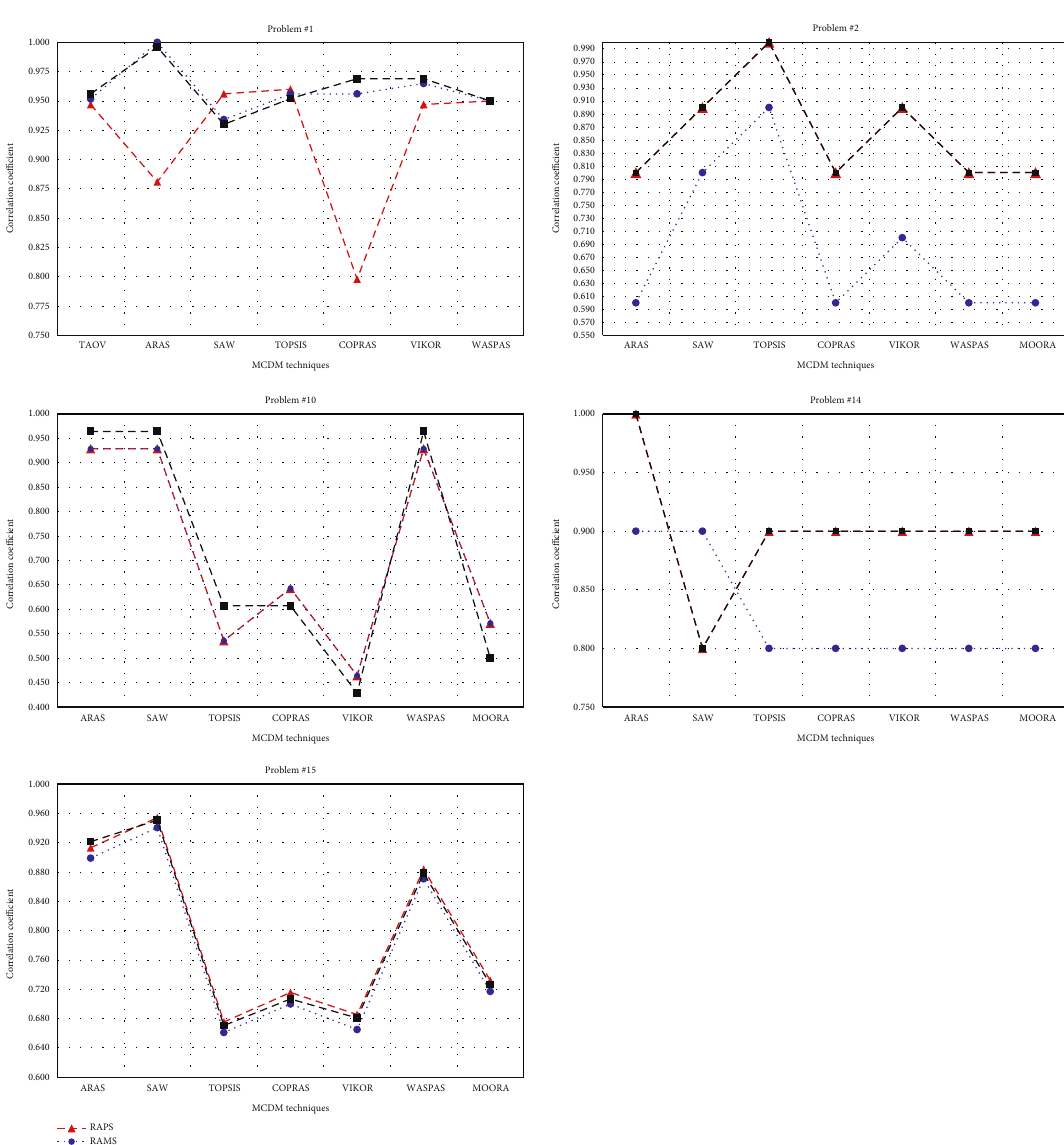
Figure 5: Relative comparison between RAPS, RAMS, and RATMI method for di ff erent